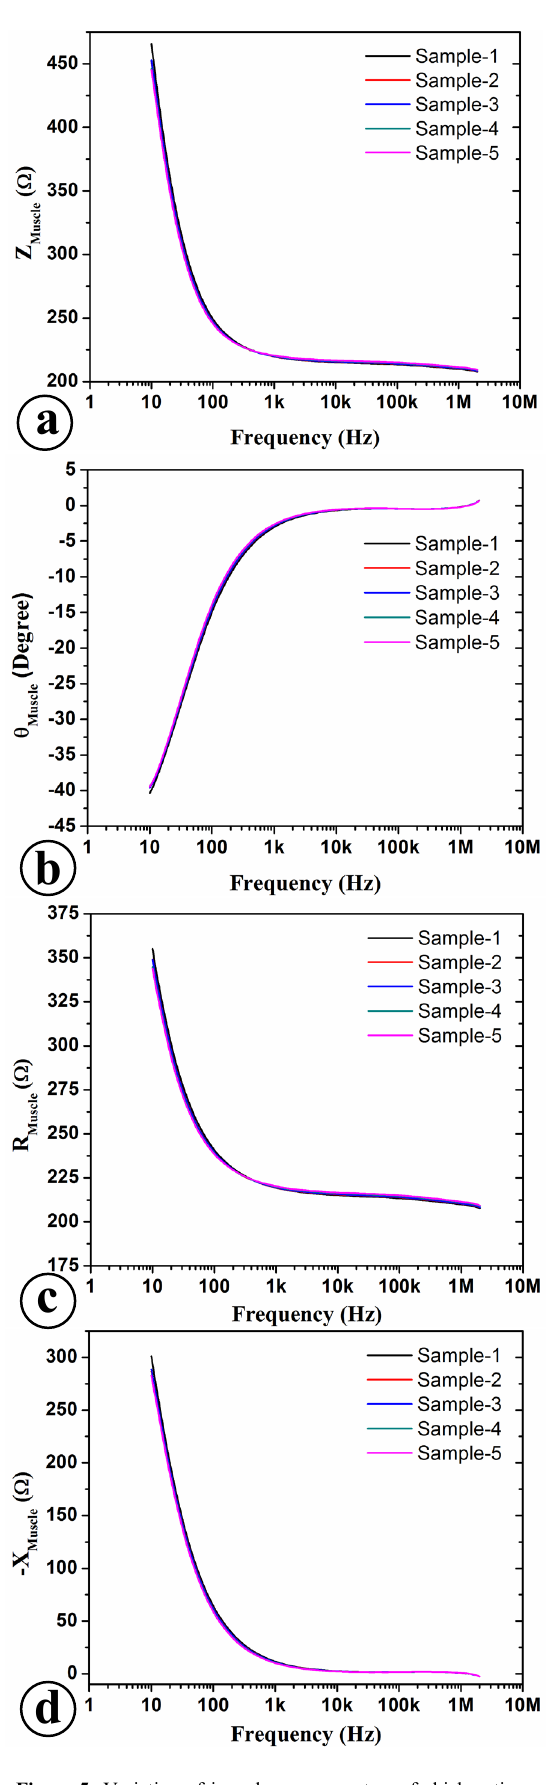
Figure-5: Variation of impedance parameters of chicken tissue paste over frequency: (a) Z Muscle Paste , (b) θ Muscle Paste , (c) R Muscle Paste , (d) X Muscle Paste